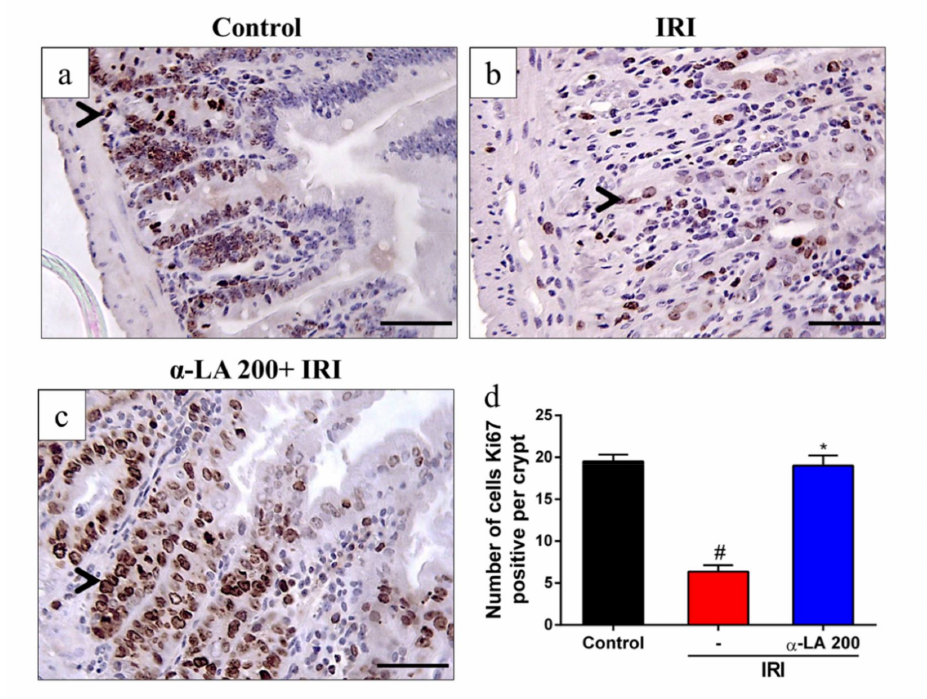
Figure 2. α -LA pretreatment decreases irinotecan-induced proliferation inhibition in the duodenum crypts in mice. ( a – c ) Representative immunohistochemistry staining for Ki67, a marker of proliferation, in sections of the duodenum of the control ( a ), IRI ( b ) and α -LA + IRI ( c ) groups. Scale bars = 50 µ m and magnification: 400 × . Black arrows point to cells immunopositive for Ki67. ( d ) Bars represent ± SEM of the number of Ki67-positive cells per crypt ( n = 4). # represents p < 0.05 versus the control group, and * indicates p < 0.05 versus the IRI group. One-way ANOVA followed by Bonferroni’s